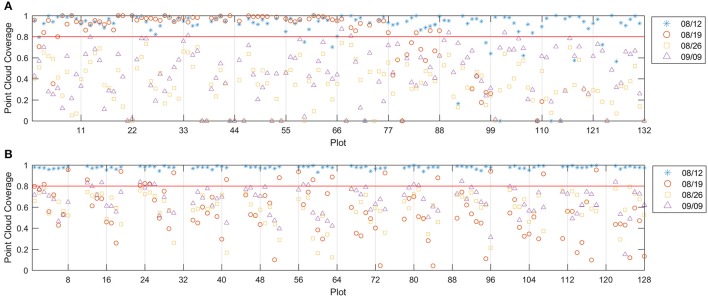
Point cloud coverage for field 1 (A) and field 2 (B). The red line indicates the 0.8 threshold.